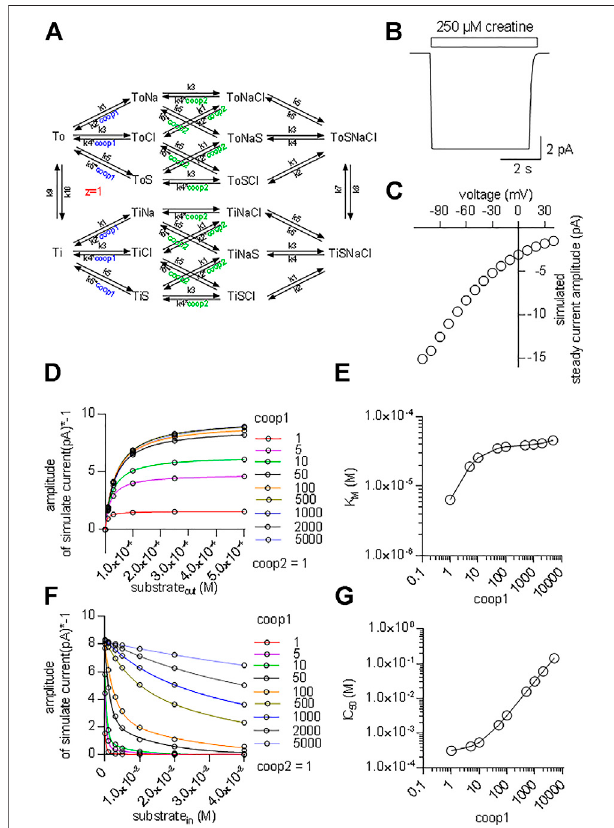
FIGURE 7 | Kinetic model of CRT-1 with cooperativity favouring stable ternary complexes. (A) Reaction scheme of the transport cycle of CRT-1. The rate constants used to parameterize the model were as follows: k1 = 10 12 M − 2 *s − 2 ; k2 = 2.5*10 7 s − 2 ; k3 = 10 6 M − 1 *s − 1 ; k4 = 5*10 3 s − 1 ; k5 = 10 7 M − 1 *s − 1 ; k6 = 2,500 s − 1 ; k7 = 100 s − 1 ; k8 = 100 s − 1 ; k9 = 5.2 s − 1 ; k10 = 5.2 s − 1 . (B) The synthetic current trace elicited by the application of 250 µM creatine was generated by the model outlined in panel A with coop1 = 500 & coop2 = 1 using the experimental conditions (ion gradients and membrane potential) employed in Figure 1A . (C) Current-voltage relation of the creatine- inducedsteadycurrentpredictedbythemodelshowninpanelAwithcoop1= 500 & coop2 = 1. (D) The reaction scheme illustrated in Panel A was used to generate the synthetic concentration-response curves for currents elicited by external creatine. In the simulations, coop1 was varied from 1 to 5,000 (as indicated in the caption) with coop2 = 1. The solid lines were drawn by fi tting the data points to the equation for a rectangular hyperbola. (E) The K M values for substrate were extracted from the curve fi tting shown in panel D and plotted as a function of the corresponding coop1 value. (F) Inhibition of the steady current amplitude as a function of the intracellular concentration of creatine. The different symbols show the results from simulations in which coop1wasvaried from1to5,000(asindicatedinthecaption)withcoop2=1. (G) The IC 50 values for internal substrate were extracted from the curve fi tting shown in panel C and plotted as a function ofthe corresponding coop1